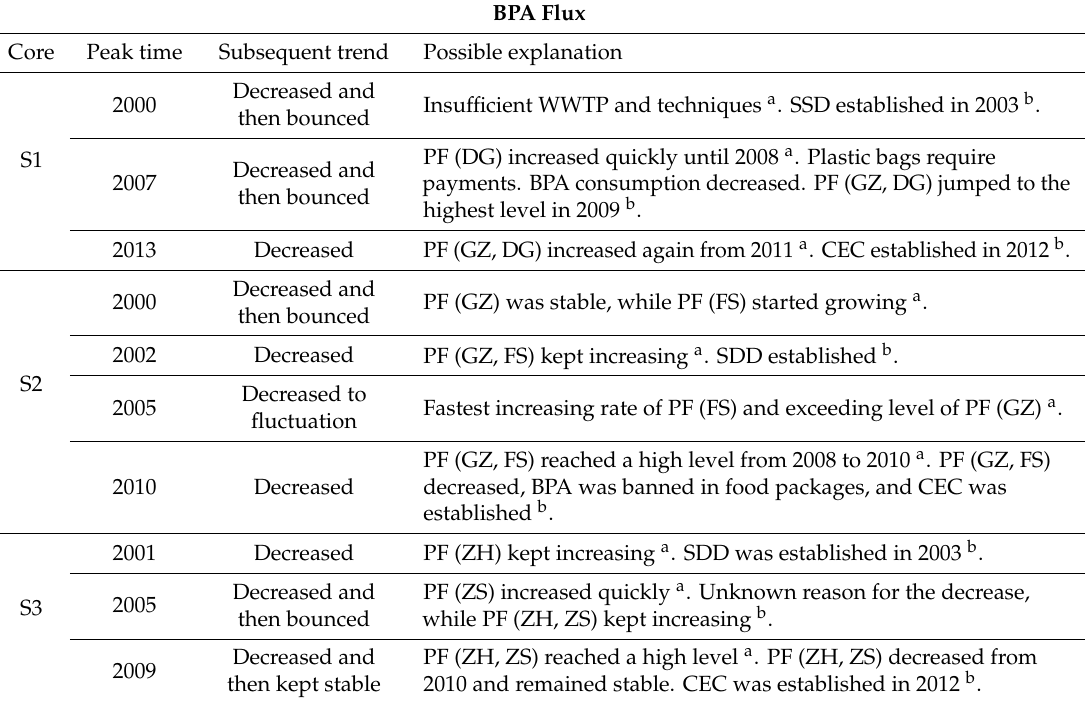
Table 4. Main features of the sedimentary records of the fluxes of BPA.